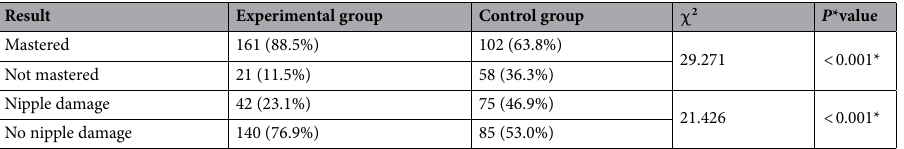
Table 2. Comparison of the mastery of the postpartum breastfeeding posture and the incidence of nipple damage. * P- value < 0.05 was considered statistically